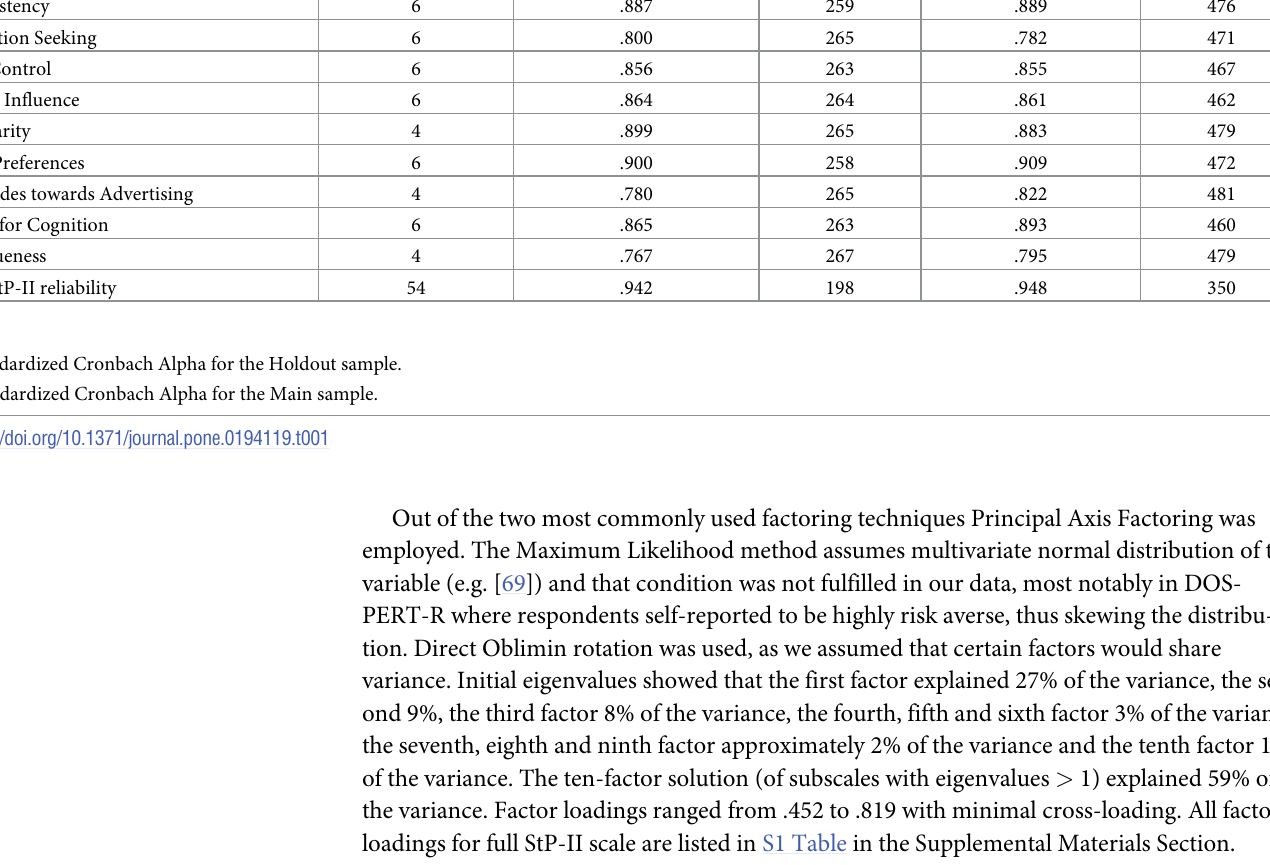
Table 2. Reliability scores for susceptibility to persuasion scale—II (Brief) on holdout (n = 278) and main (n = 500) samples.